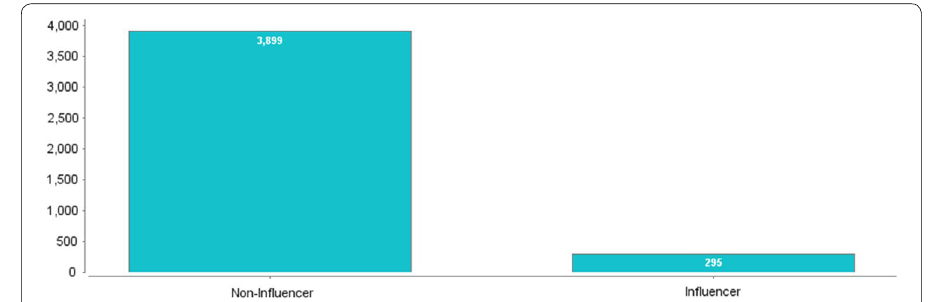
Fig. 3 Number of influencers and non‑influencers in IT